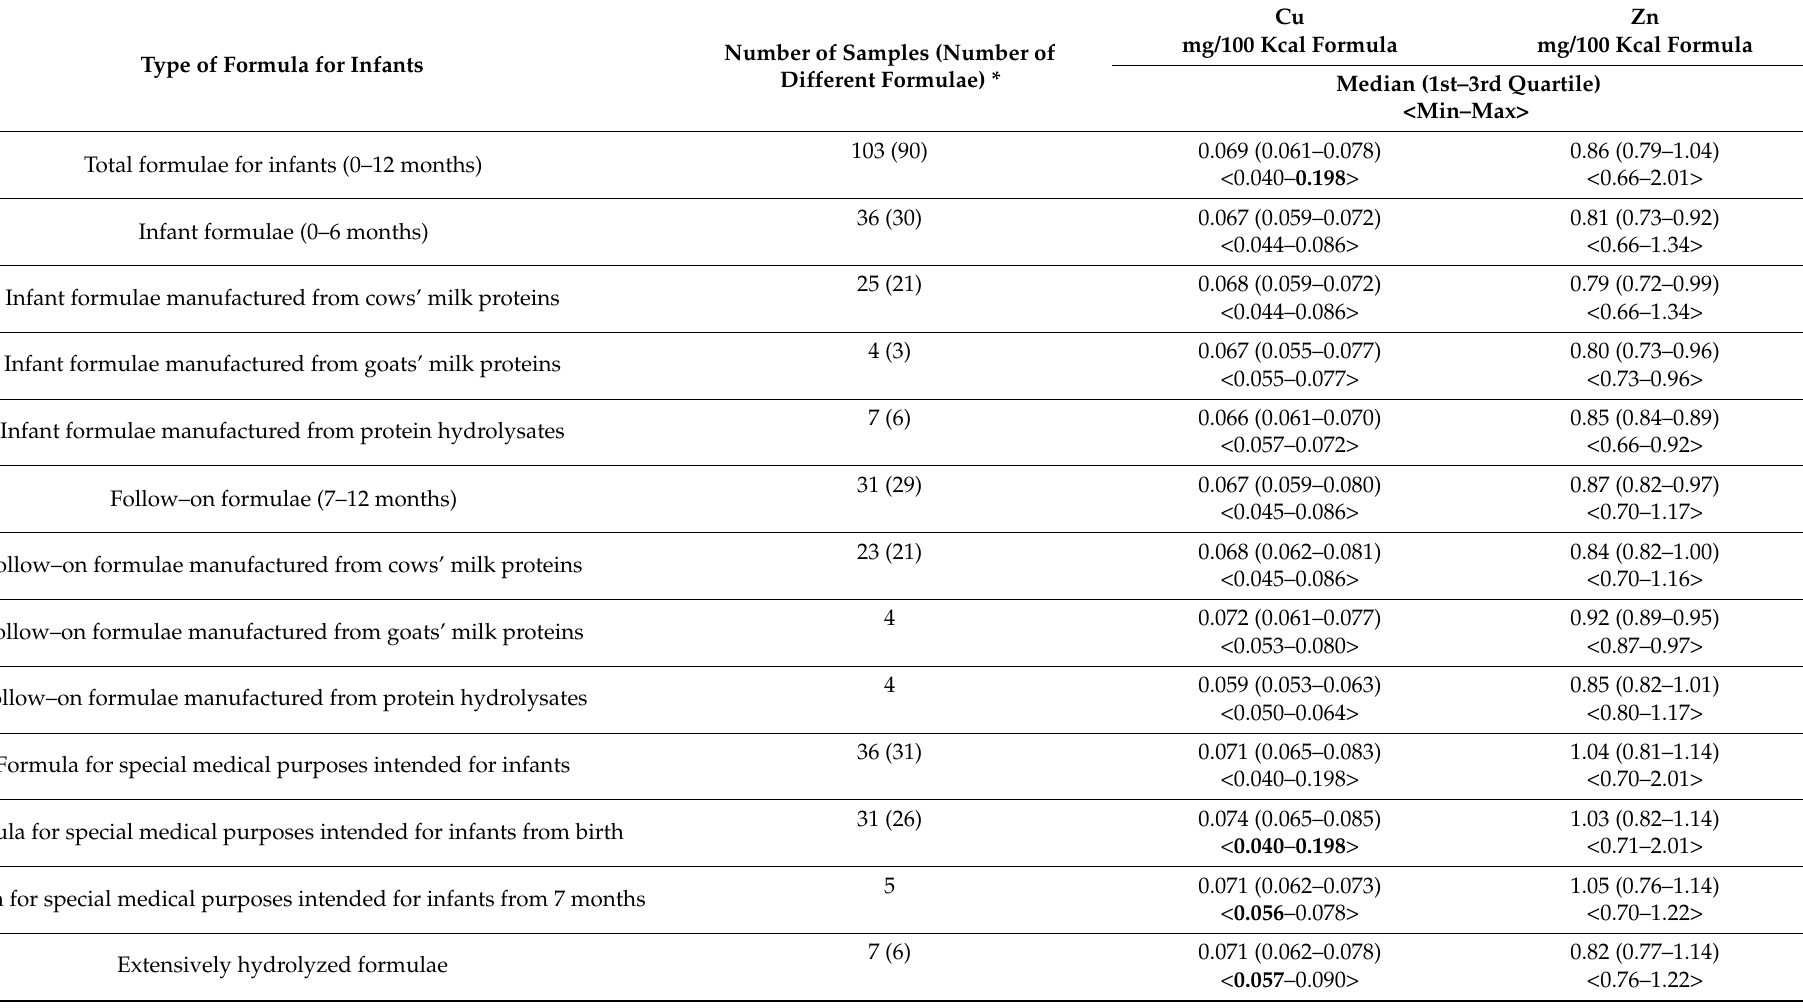
Table 2. Copper and Zinc concentration (mg/100 kcal formula) in different types of formula for infants (values that do not meet the recommendation are shown in